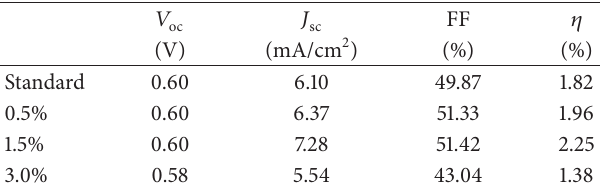
Table 1: Photovoltaic performance of investigated OPVDs doped with nanodiamond at various concentrations measured under AM1.5G at 100 mW ⋅ cm − 2